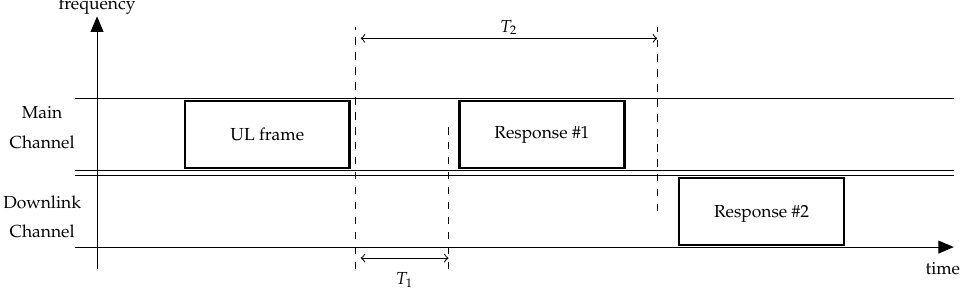
Figure 9. Class A transmission procedure in